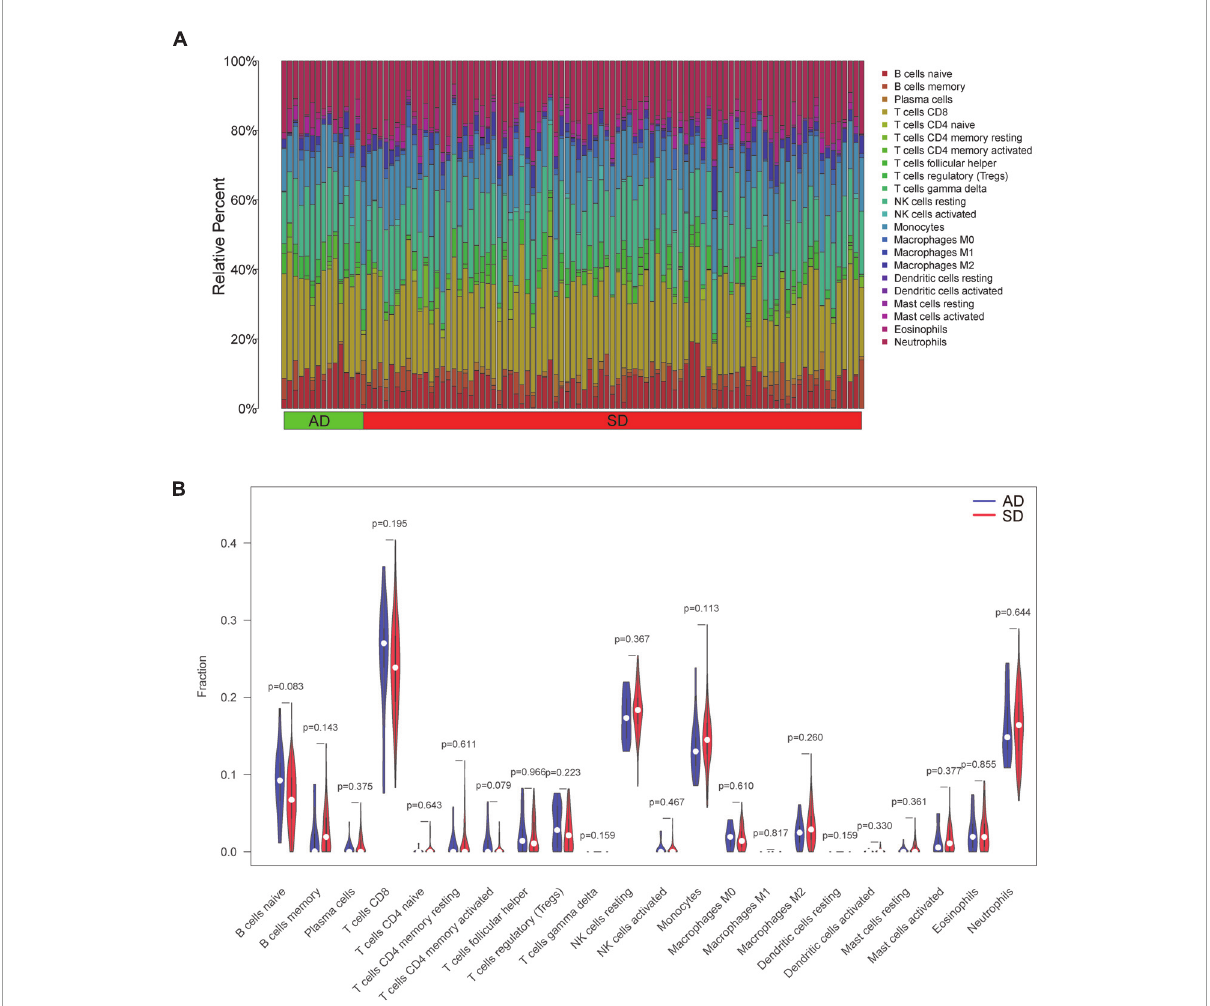
FIGURE6 Profile and visualization of immune cell infiltration. (A) The infiltration of 22 immune cells after quantification by the CIBERSORT algorithm. (The X-axis represents the sample and the Y-axis shows the percentage of 22 immune cells in the sample as stacked bars). (B) Violin plot showing comparison based on 22 immune cells. (Blue and red represent AD and SD group samples, respectively). AD, Accidental death; SD, Sudden